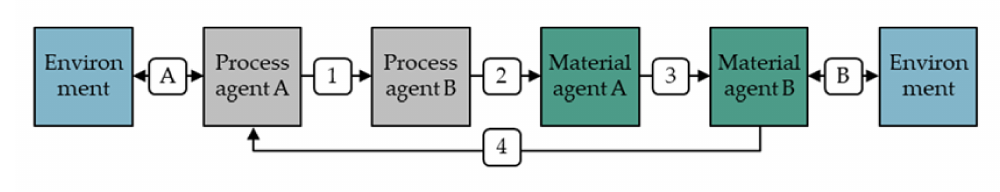
Figure 7. Exemplary agent interactions for this simulation